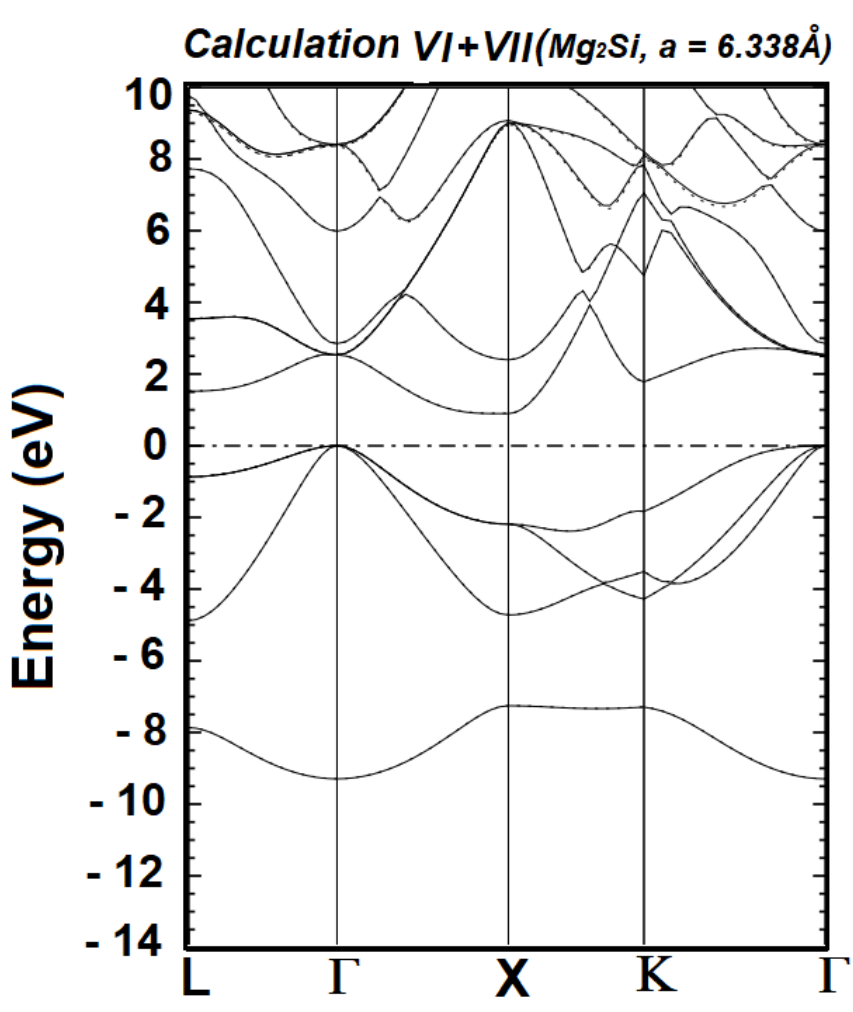
Figure 3. Electronic band structure of cubic Mg 2 Si, obtained from Calculations VI (solid lines) and VII (dotted lines), for a room temperature experimental lattice constant of 6.338 Å, using the BZW-EF method. The Fermi level has been set to zero and its position is denoted by the horizontal dashed- dotted line. The calculated band gap, as obtained with the optimal basis set of Calculation VI, is from the Γ point to the X point, with a value of 0.896eV.